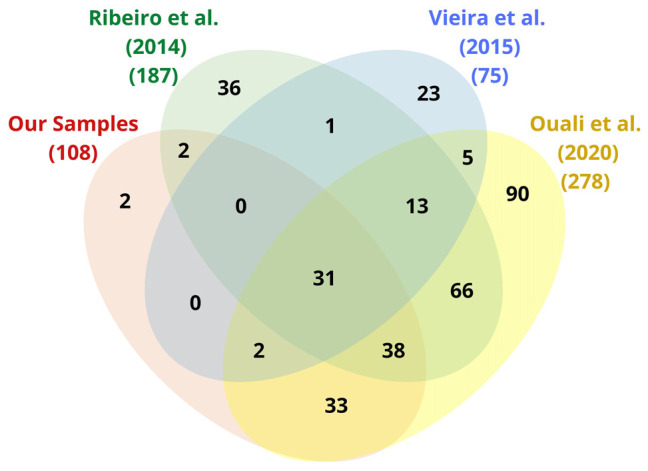
Venn diagram (Interactivenn) of complete EC annotations from our samples and those of Ribeiro et al. (2014), Vieira et al. (2015), and Ouali et al. (2020). The total number of enzyme functions (ECs) is indicated beside each ellipse.